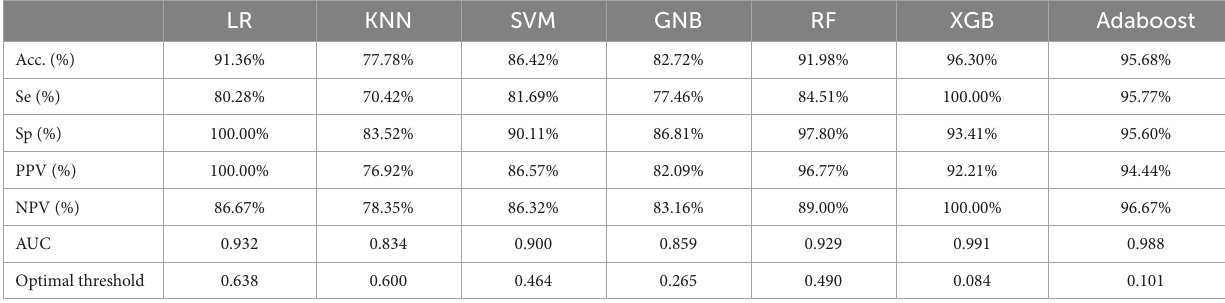
TABLE 6 Performance of classifier implementation on task 2.